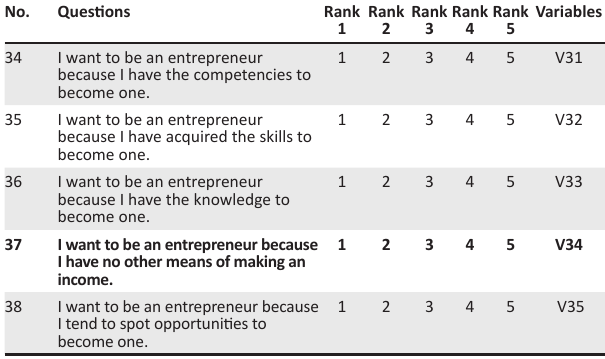
FIGURE 6: Influence on entrepreneurial intention by programme duration. TABLE 8: Entrepreneurial intention factor